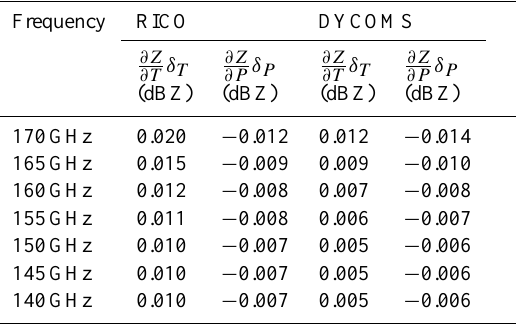
Table 3. Uncertainty in the radar reflectivity due to 2K bias in tem- perature or a 5hPa bias in pressure. Temperature and pressure biases are applied uniformly throughout the atmospheric column and radar reflectivities are calculated from the perturbed state. The radar re- flectivity uncertainties shown in the table are the mean of all pixels in each LES.